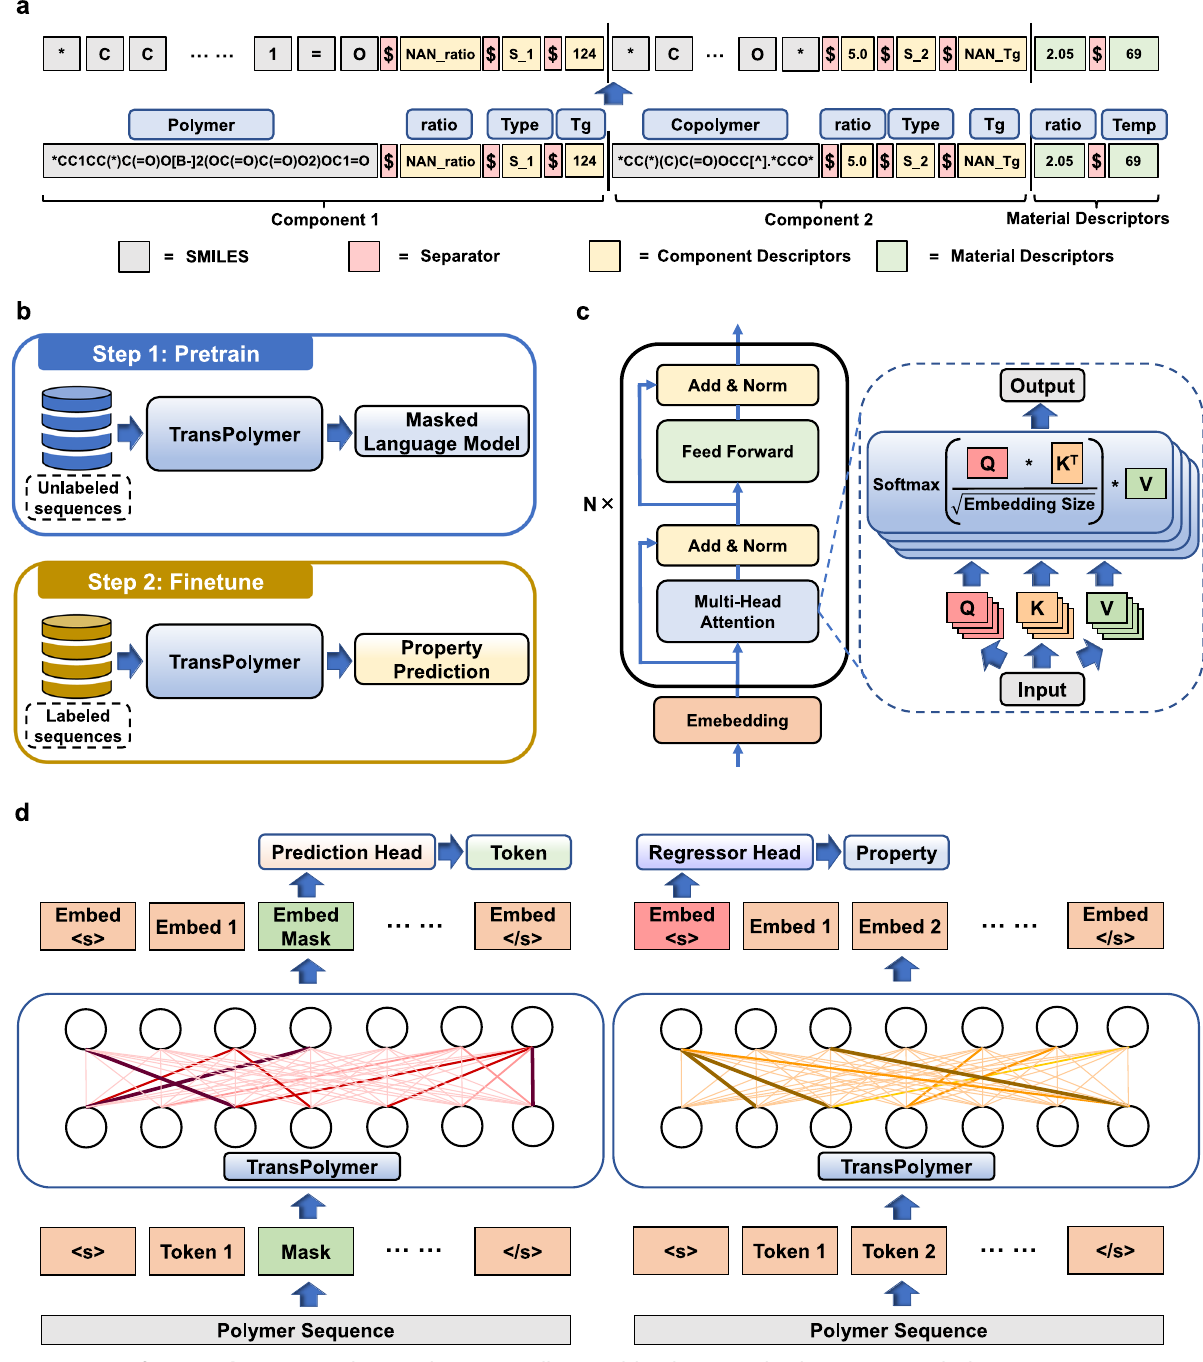
Fig. 1 Overview of TransPolymer. ( a ) Polymer tokenization. Illustrated by the example, the sequence which comprises components with polymer SMILES and other descriptors is tokenized with chemical awareness. b The whole TransPolymer framework with a pretrain- fi netune pipeline. c Sketch of Transformer encoder and multi-head attention. d Illustration of the pretraining (left) and fi netuning (right) phases of TransPolymer. The model is pretrained with Masked Language Modeling to recover original tokens, while the feature vector corresponding to the special token ‘ 〈 s 〉 ’ of the last hidden layer is used for prediction when fi netuning. Within the TransPolymer block, lines of deeper color and larger width stand for higher attention